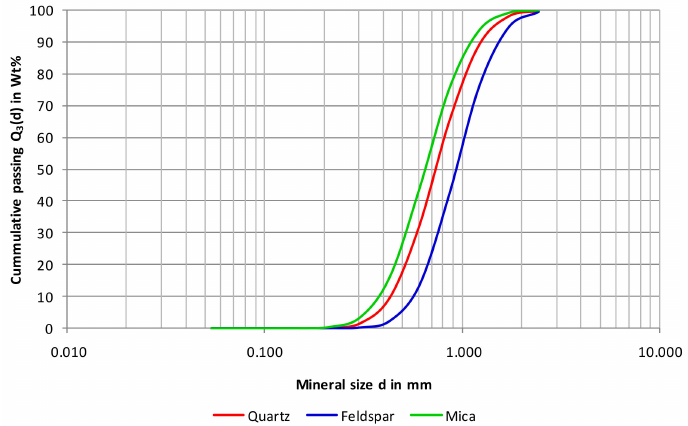
Figure 10. Mineral grain size distribution of